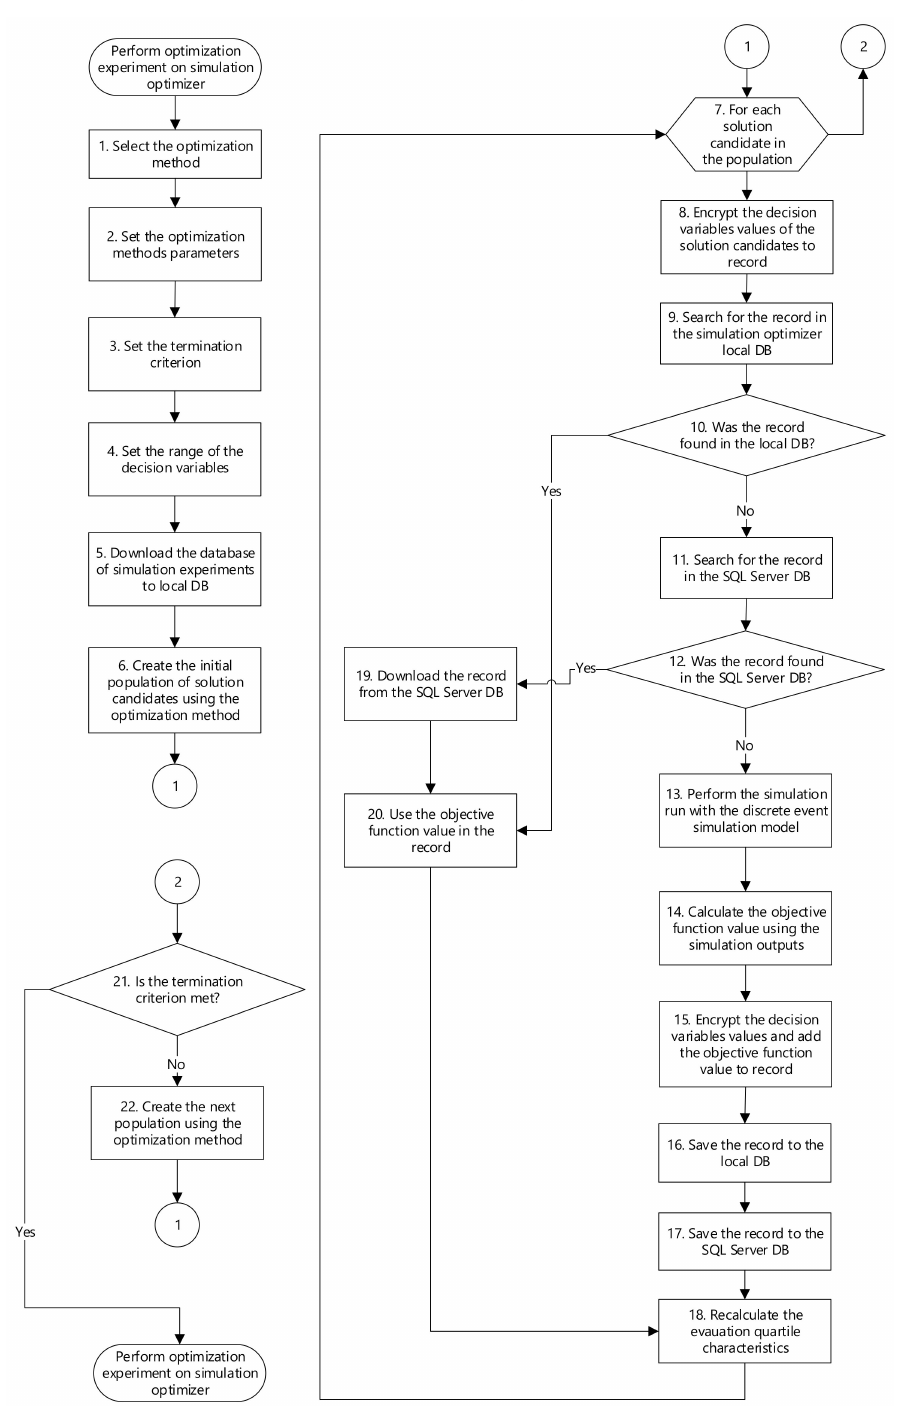
Figure 9. Flowchart of the optimisation experiment on the parallel simulation